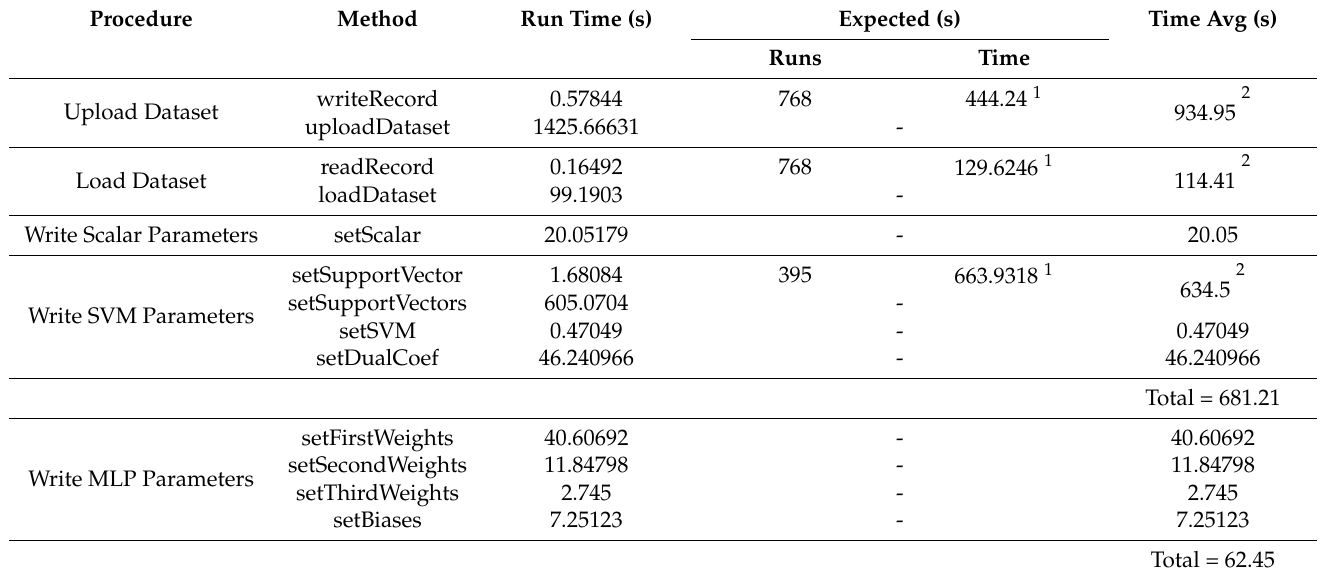
Table 6. Elapsed time for methods’ executions.